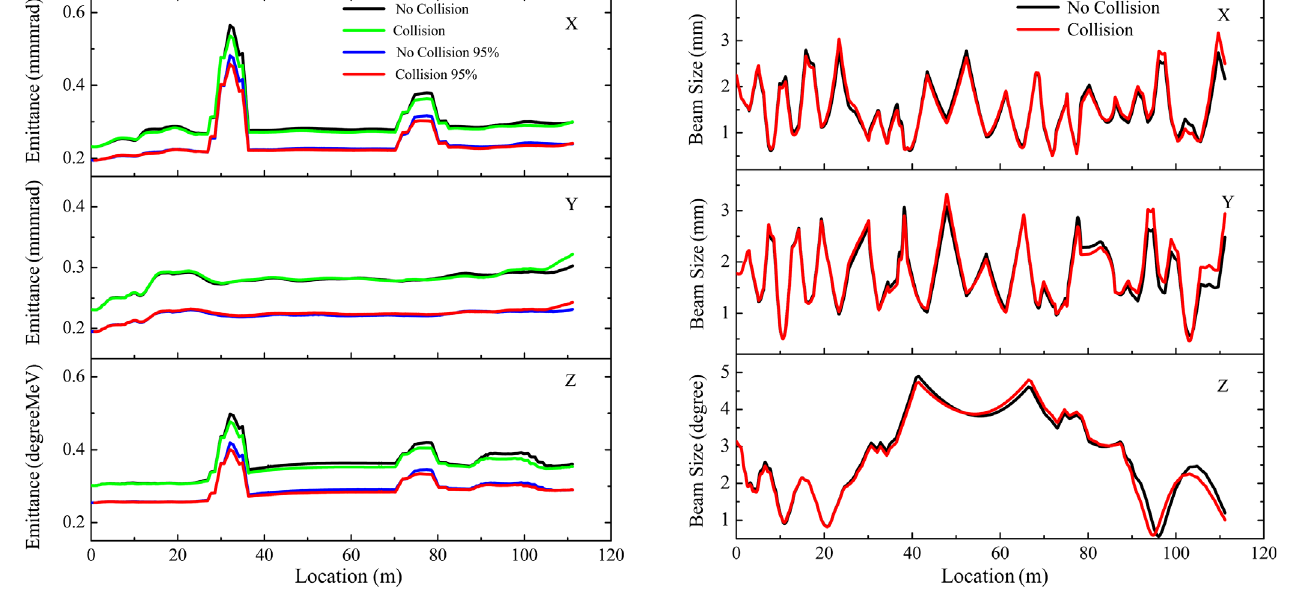
FIG. 8. The rms size evolution of the single-bunch simulation and the simulation including multiple collisions through the double-pass